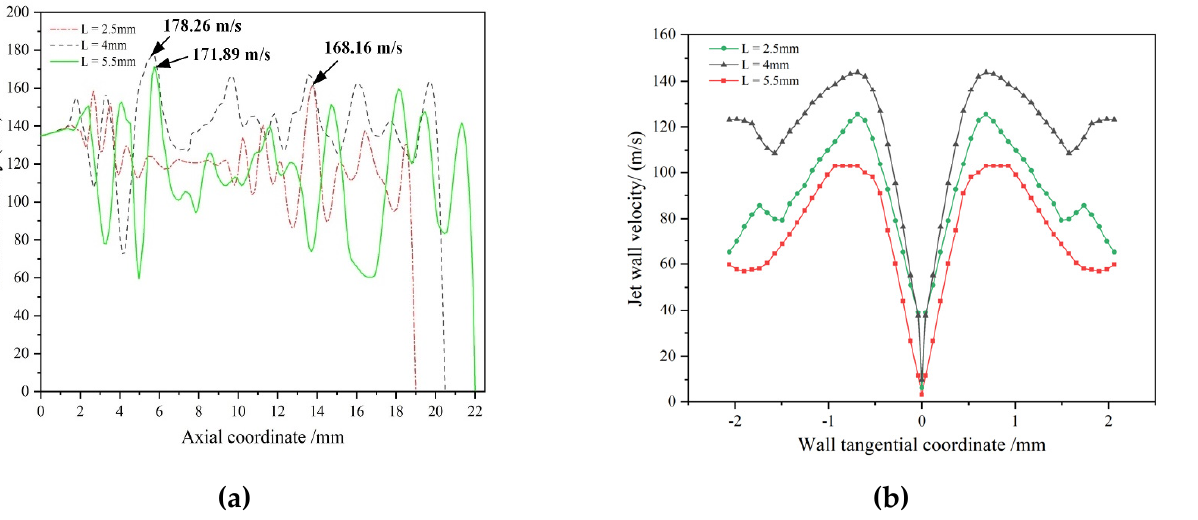
Figure 6. Jet axial and wall velocity curves under three cavity lengths. Axis velocity ( a ). Processing wall velocity ( b ).